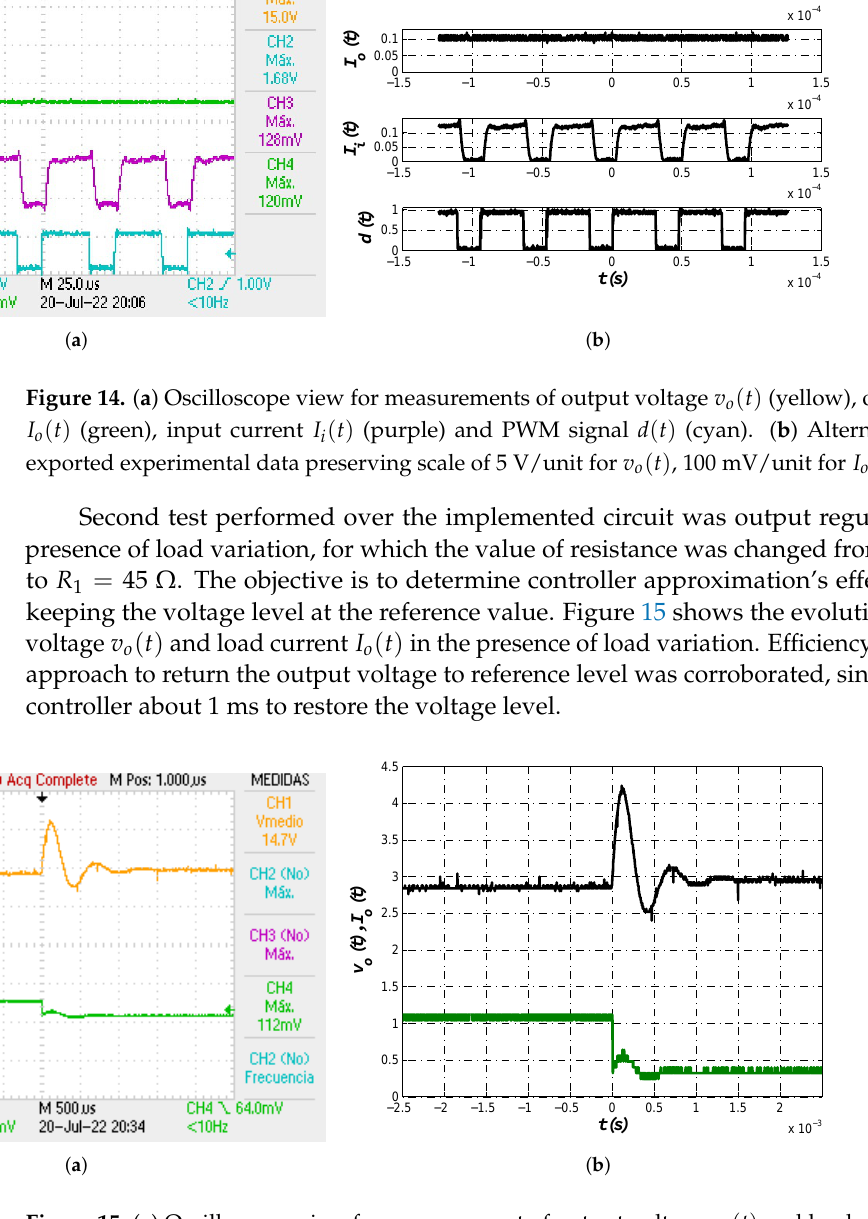
Figure 15. ( a ) Oscilloscope view for measurement of output voltage v o ( t ) and load current I o ( t ) in the presence of load variation. ( b ) Alternative view of output voltage v o ( t ) and load current I o ( t ) from exported